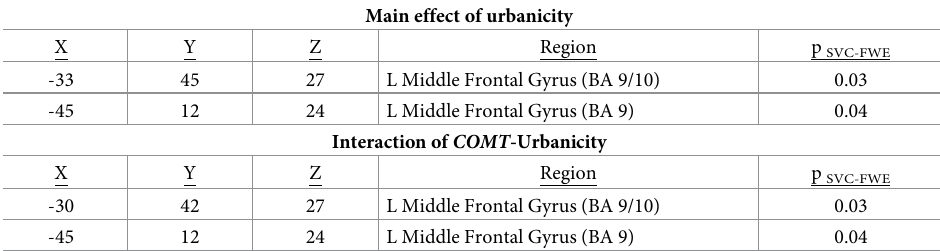
Table 2. Urbanicity and COMT interaction effects at discovery (n = 124).